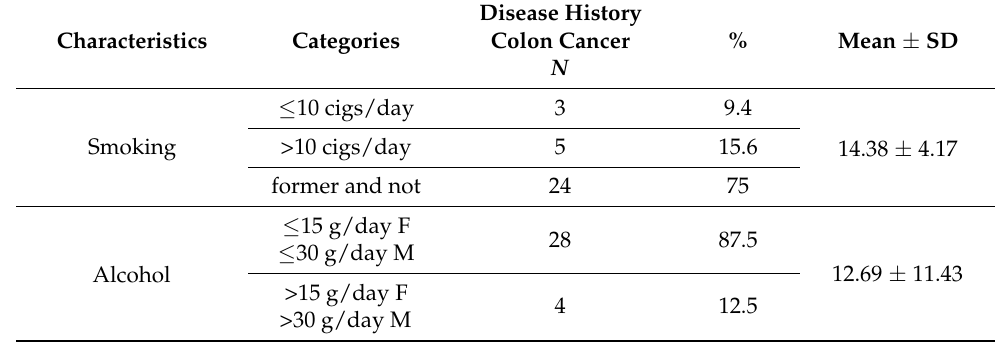
Table 2. Demographic and lifestyle characteristics of the study